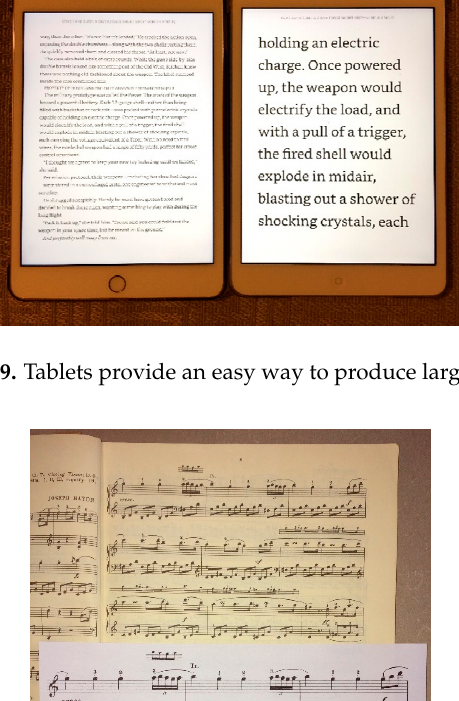
Figure 8. Adult, using reading glasses.